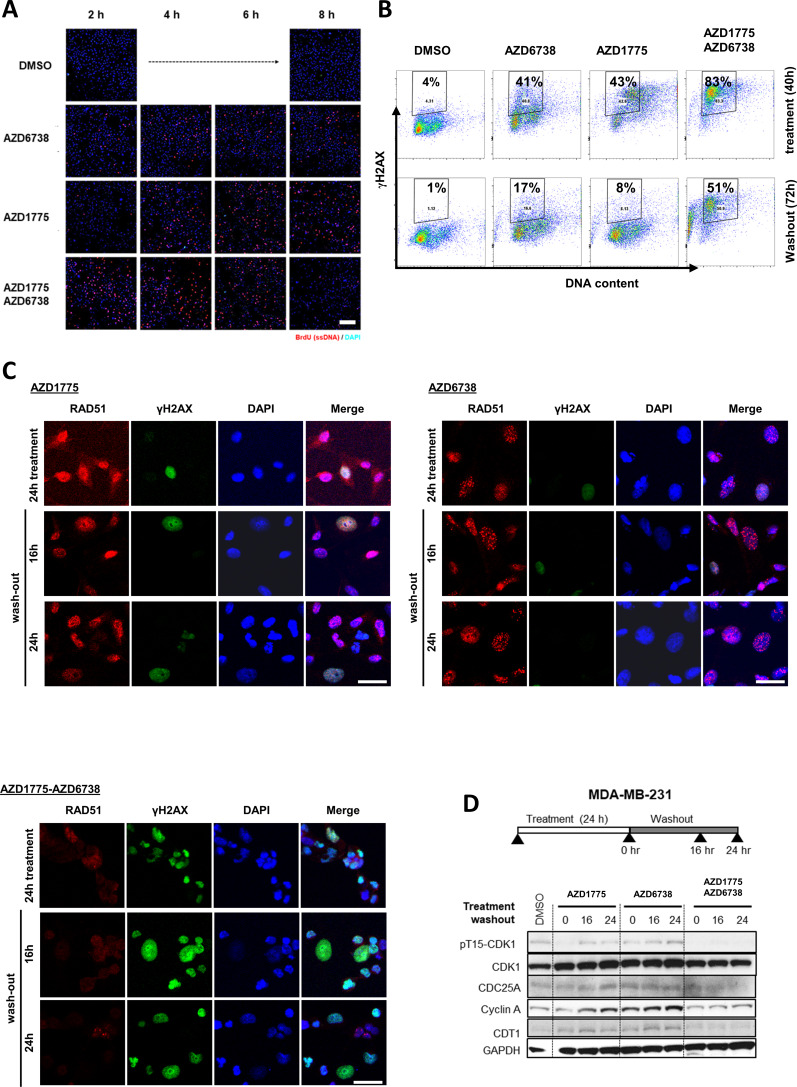
ATR inhibition by AZD6738 exacerbates AZD1775-induced RS and abrogates recovery of replication.(A) Lower-magnification of immunofluorescence images related to Figure 3E visualizing ssDNA-positive MDA-MB-231 cells by native BrdU staining (red) in response to AZD1775, AZD6738 or the combination treatment as indicated. Scale bar = 200 μM. (B) γH2AX staining was assessed by flow cytometry in MDA-MB-231 cells treated with the indicated drugs for 40 hr and following drug washout (72 hr) to assess DNA damage. Representative FACS data (two independent experiments) are shown and the percentage of γH2AX-positive cells are indicated in gated dot-plots. (C) Representative images of immunofluorescence staining for γH2AX (green), RAD51 (red) and DAPI (blue) quantifications in Figure 3F. MDA-MB-231 cells were treated with AZD1775 (500 nM), AZD6738 (1 μM) or their combination for 24 hr followed by 16 and 24 hr of drug wash-out. Merged images are separated by white lines. Scale bar = 30 μM. (D) Expression levels of cycle regulatory proteins including CDC25A, cyclin A, CDT1 and phosphorylation of CDK1-Y15 and γH2AX during the course of recovery following treatment with AZD1775 (500 nM), AZD6738 (1 μM), or their combination, were analysed by western blotting in recovering MDA-MB-231 cells. GAPDH expression level served as loading control.